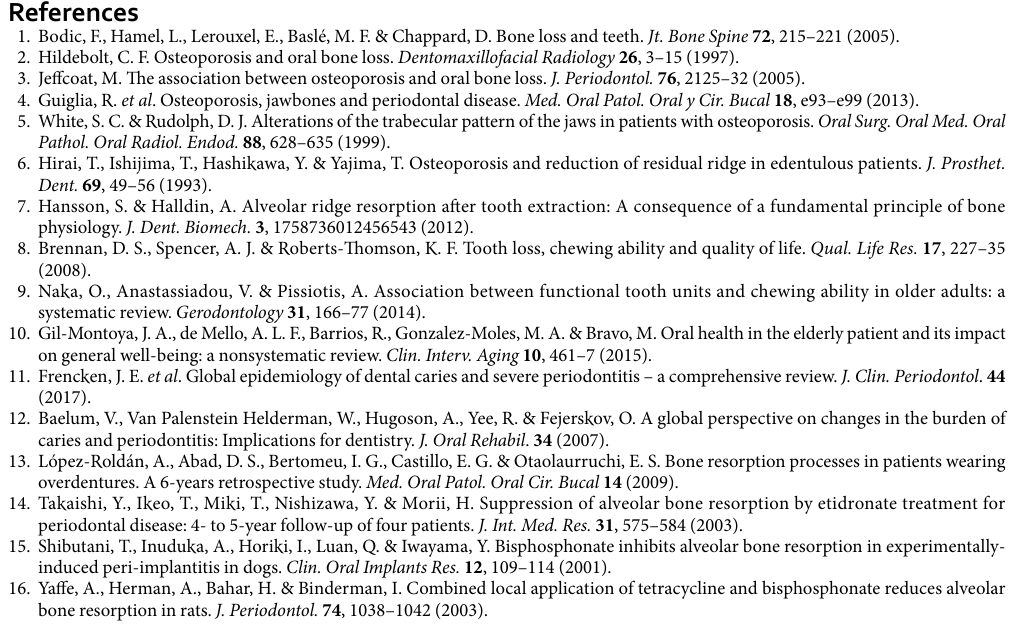
inter-root bone in the anterio-posterior direction was included. This method enabled construction of VOI which followed curved trajectories in three dimensions, and widened/tapered through thicker/thinner sections of the mandible. This was performed through the whole tooth row in the majority of the species, with the exception of the mangabey and human where, due to the presence of partially erupted 3 rd molars, the tooth row was defined between the 1 st premolar and 2 nd molar. The VOI were divided into a premolar and molar VOI based on the borders of the premolar and molar roots when viewed in the sagittal plane. The parameters of BV/TV and RV/TV were then calculated in each VOI within AVIZO.